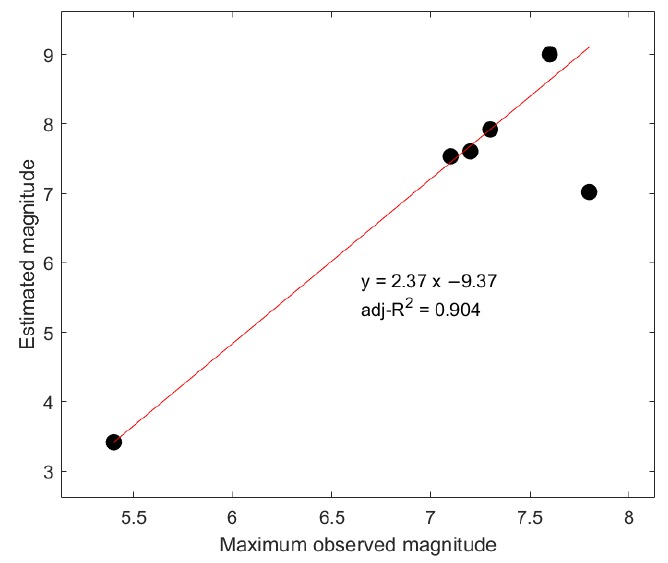
Figure 12. Comparison of the estimated magnitude by FIS algorithm and the real observed magnitude. The validation case study was also included. A linear fit with its output coefficients and adjusted coefficient of determination is also provided. Table 3. Estimated magnitudes and comparison with the real one after